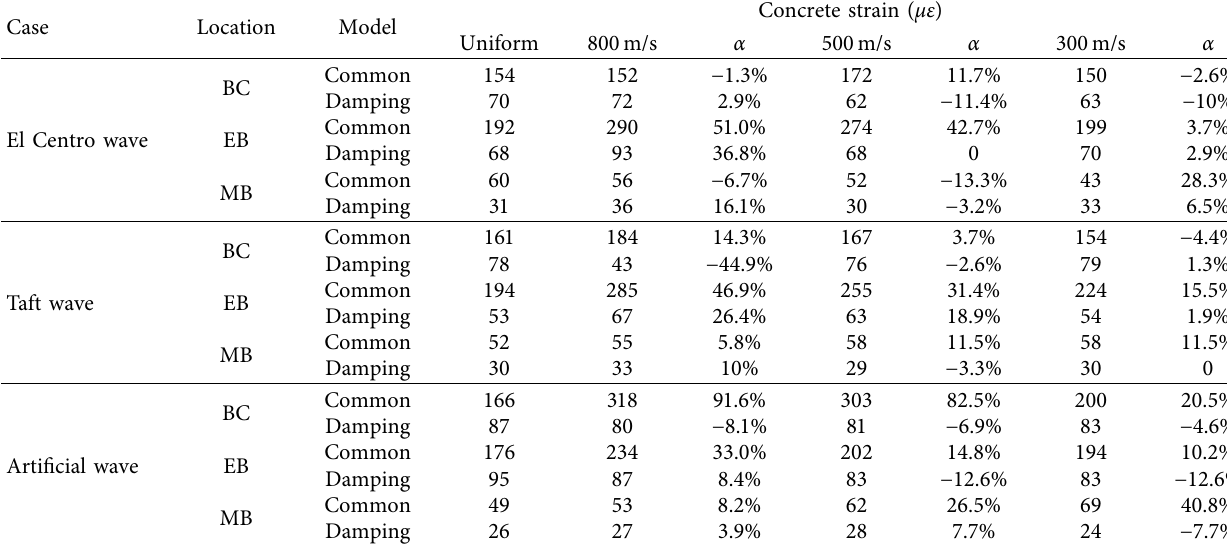
Table 7: Peak strain response of key